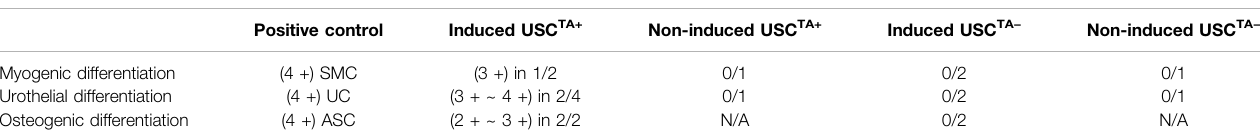
TABLE 4 | Induced and non-induced multipotent differentiation potential of